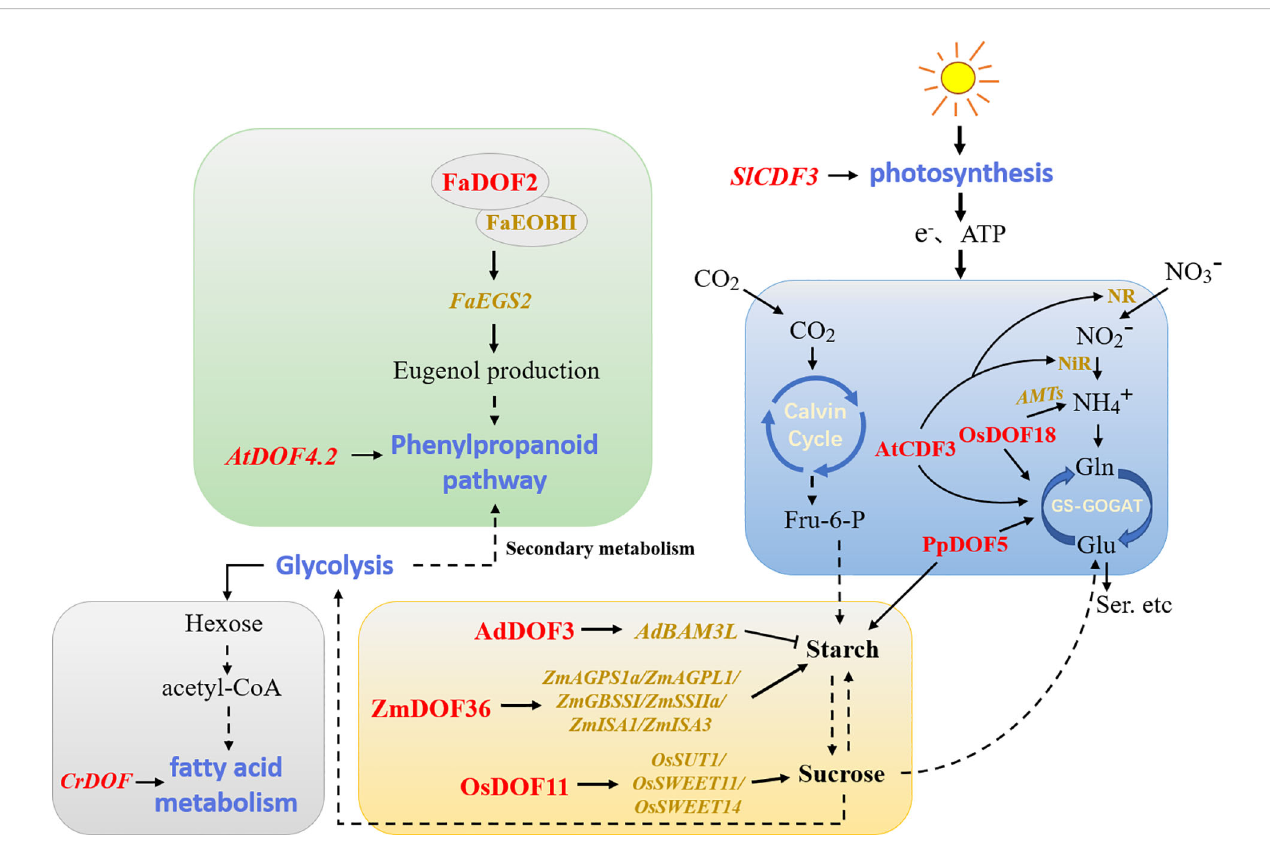
FIGURE 4 Model of DOFs involved in the regulation of plant metabolism. The blue, yellow, grey, and green modules represent carbon and nitrogen assimilation, carbohydrate metabolism, fatty acid metabolism, and phenylpropanoid metabolism, respectively. Red indicates DOF members in different plants. Dotted lines indicate that some processes have been omitted. NR/NiR, nitrate/nitrite reductases; AMTs, ammonium transporters; GS, glutamine synthetase; GOGAT, glutamate synthase; Fru-6-P,